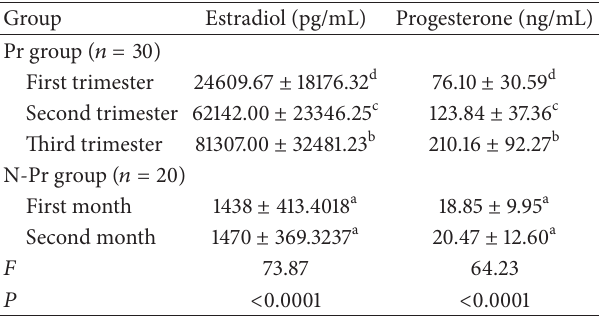
Table 5: Serum estradiol and progesterone in pregnant group and nonpregnant group ( 𝑥 ± 𝑠